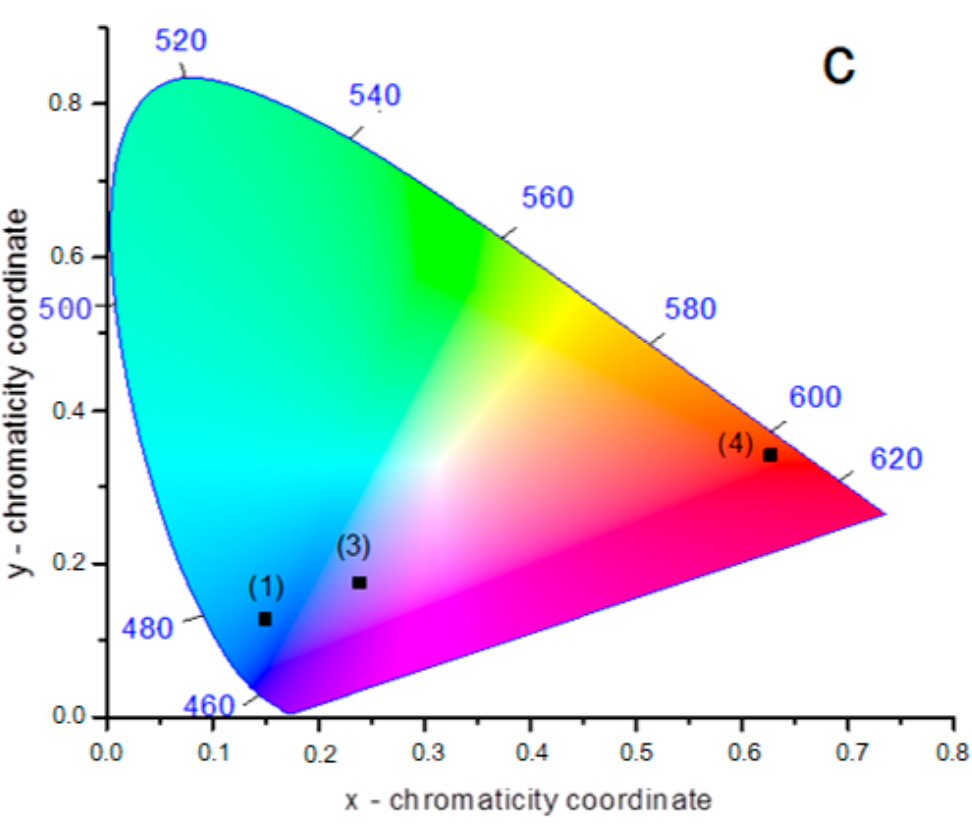
Figure 10. CIE chromaticity diagram for ( 1 / 2 ) (x = 0.150, y = 0.128), ( 4 ) (x = 0.238, y = 0.175), ( 5 ) (x = 0.627, y =